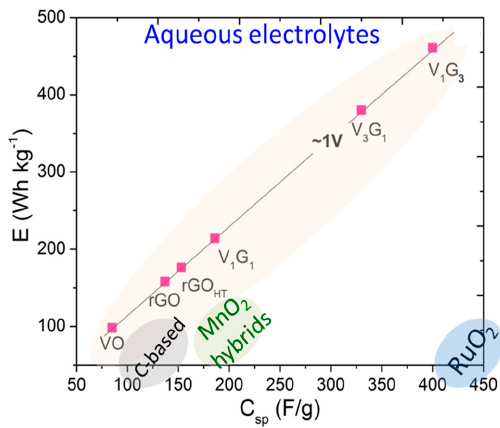
Figure 8. Specific energy density versus specific capacitance behavior along with other relevant materials in aqueous electrolyte for comparison. Table 2. Summary of ac impedance spectroscopy data simulations with Randel’s circuit element parameters.